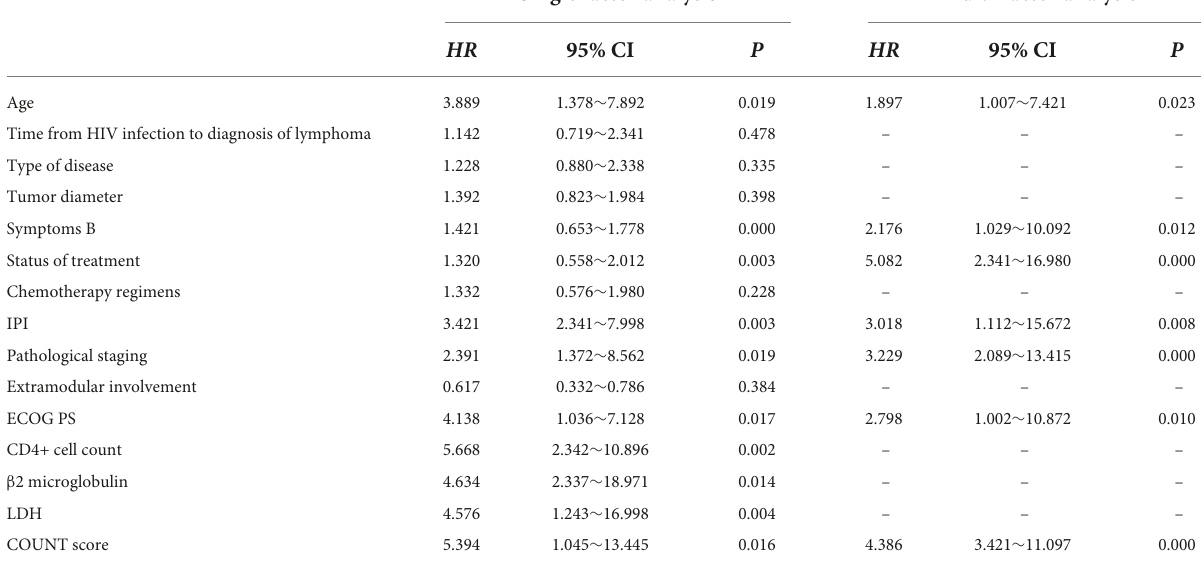
TABLE 3 Regression analysis of factors influencing the prognosis of patients with human immunodeficiency virus (HIV) infection-associated lymphoma.